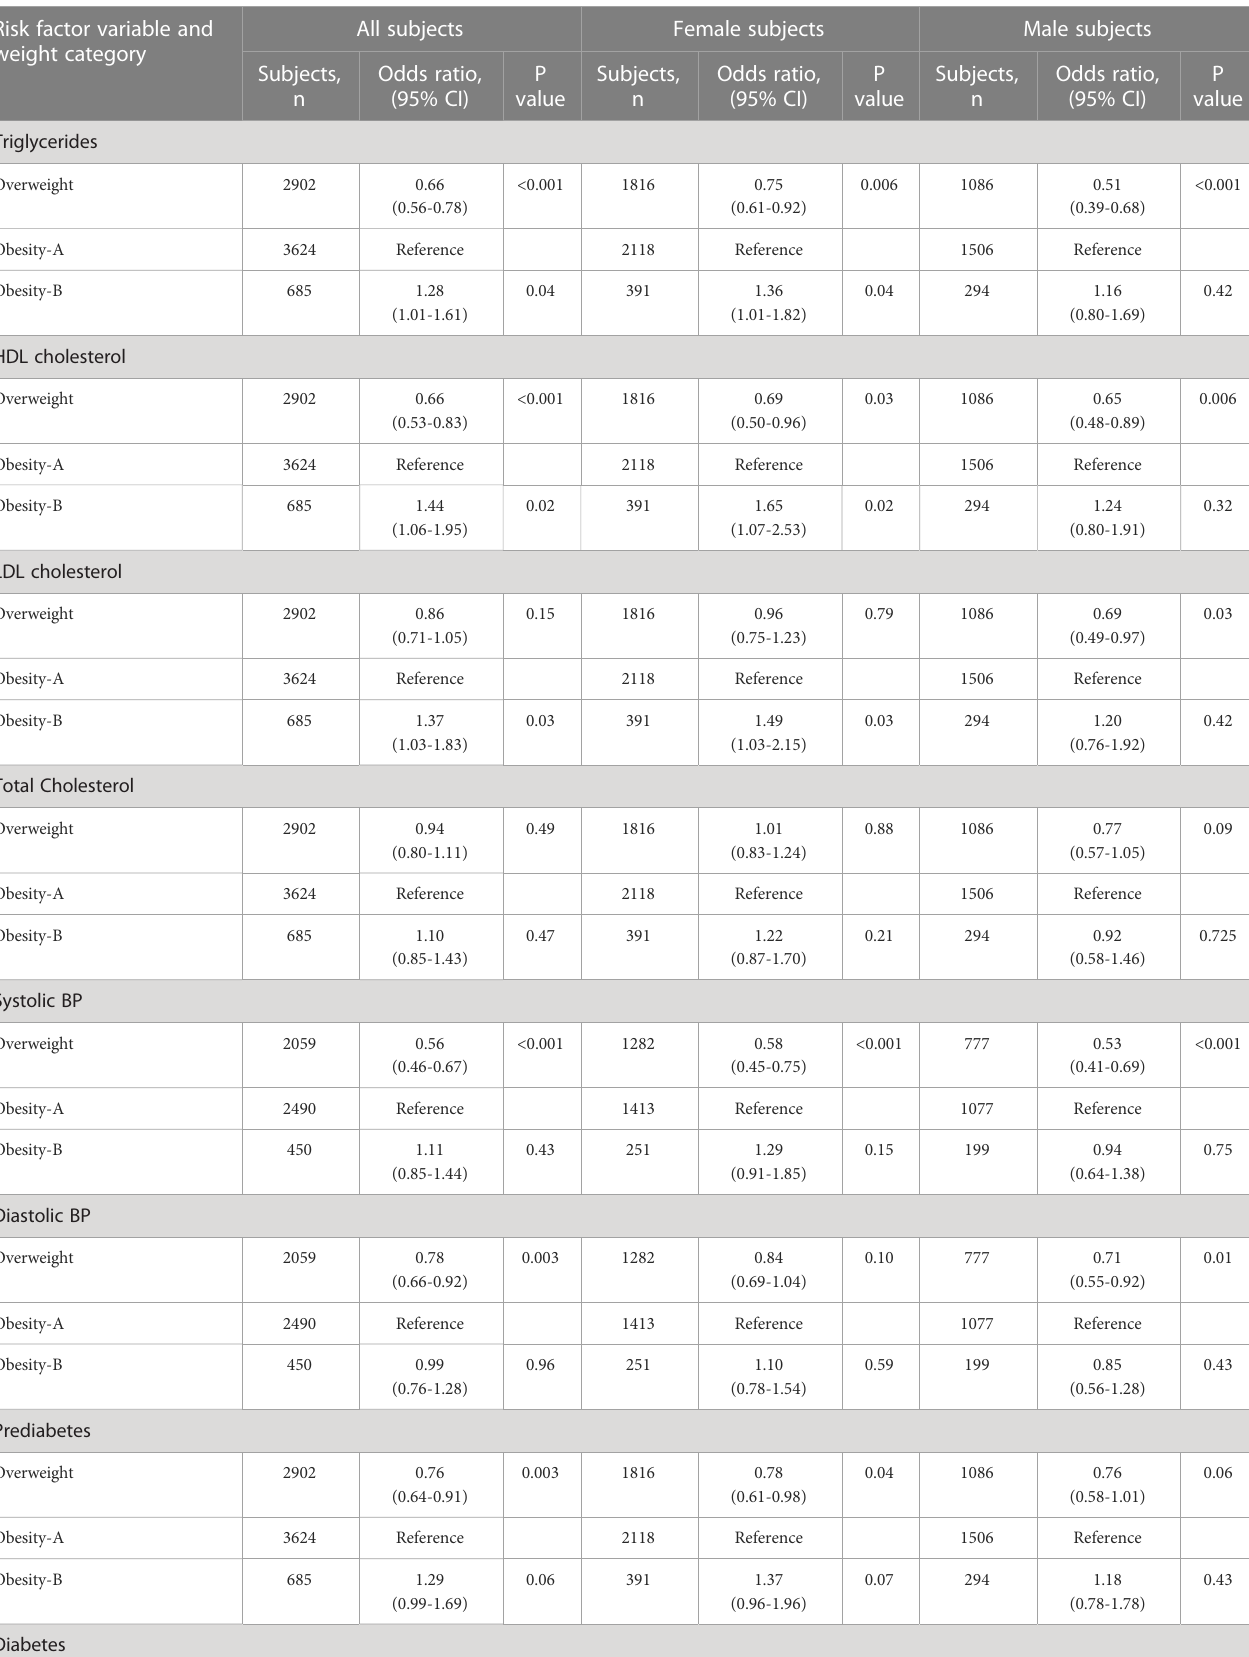
TABLE 4 Odds ratios for cardiometabolic risk factors among children and adolescents by sex and